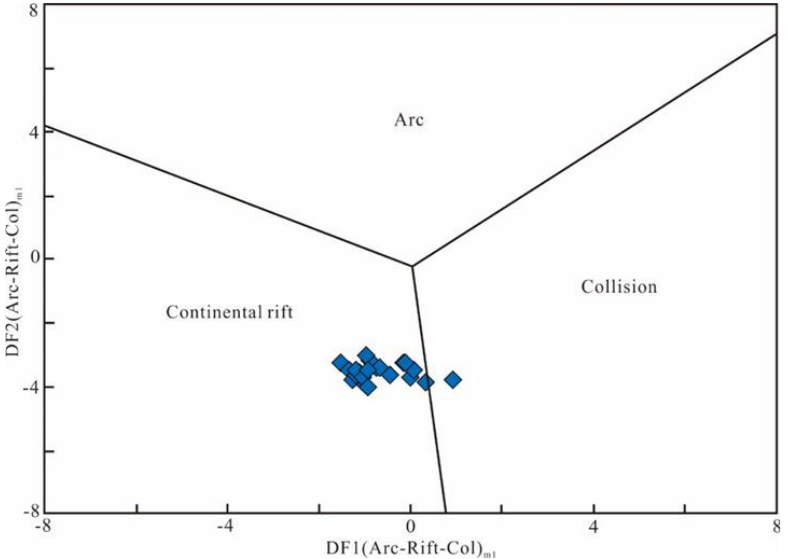
Figure 13. Tectonic setting discrimination of Zhiluo Formation [47]. DF1(Arc-Rift-Col) m1 = ( − 0.263) × ln(TiO 2 /SiO 2 )adj + 0.604 × ln(Al 2 O 3 /SiO 2 )adj + ( − 1.725) × ln(Fe 2 O 3T /SiO 2 ) adj + 0.660 ×